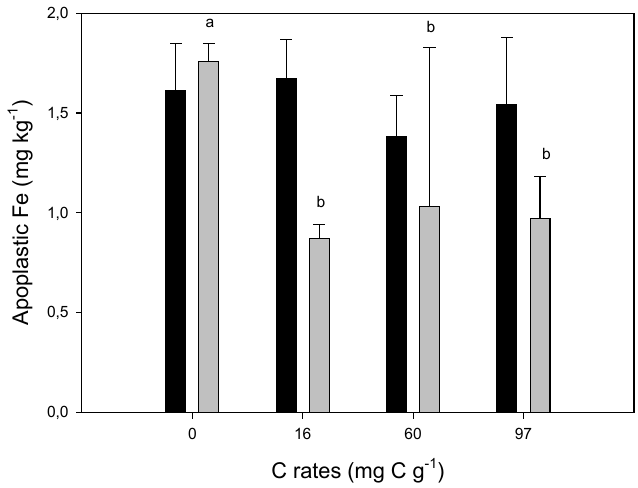
Fig. 2 Effect of the different rate of Fe-HS on concentration of apoplastic Fe in roots of lupin (black columns) and wheat (grey columns). One-way ANOVA was performed for each plant independently. Means with different letter were significantly different as per LSD test at p < 0.05. Error bars indicate one standard